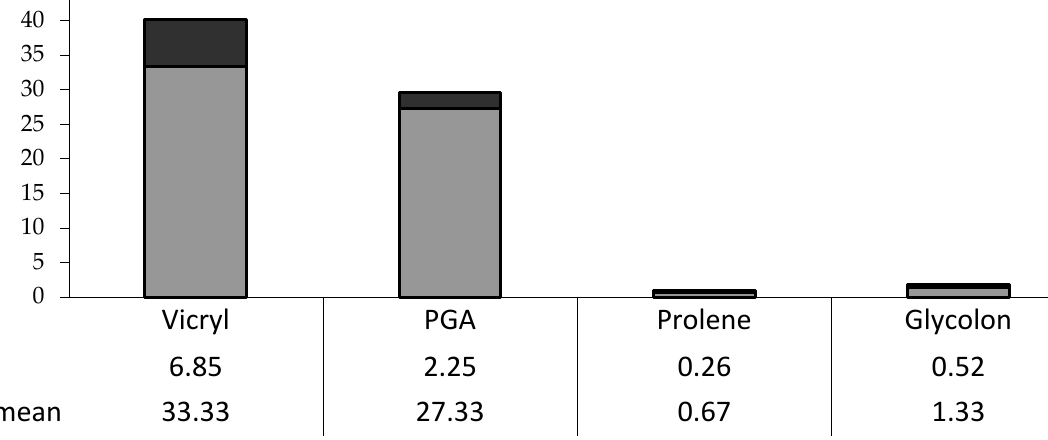
Figure 3. Diagram of the capillarity of each material in mm (mean ± SD).